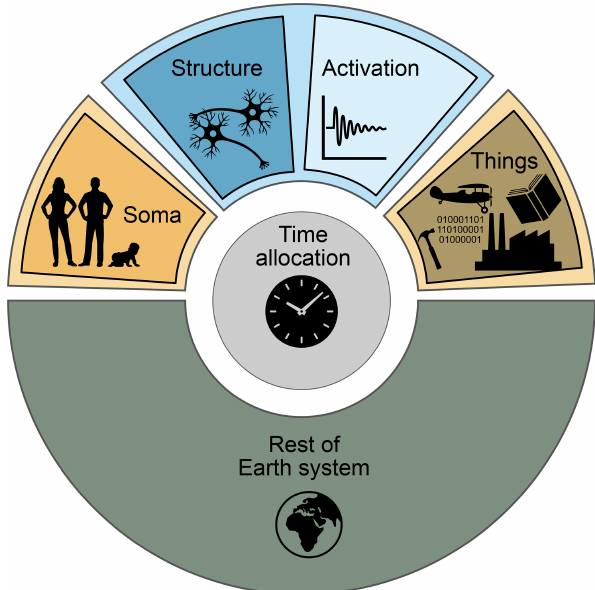
Figure 2. The superstructure of the conceptual framework. Each of the six shaded regions corresponds to a state variable class. Vari- ables in the blue regions relate to the persistent structure and instan- taneous activation of human neural systems, the orange region to human bodies, the brown region to human-created things, the grey to the distribution of time amongst activities, and the green to the remainder of the Earth